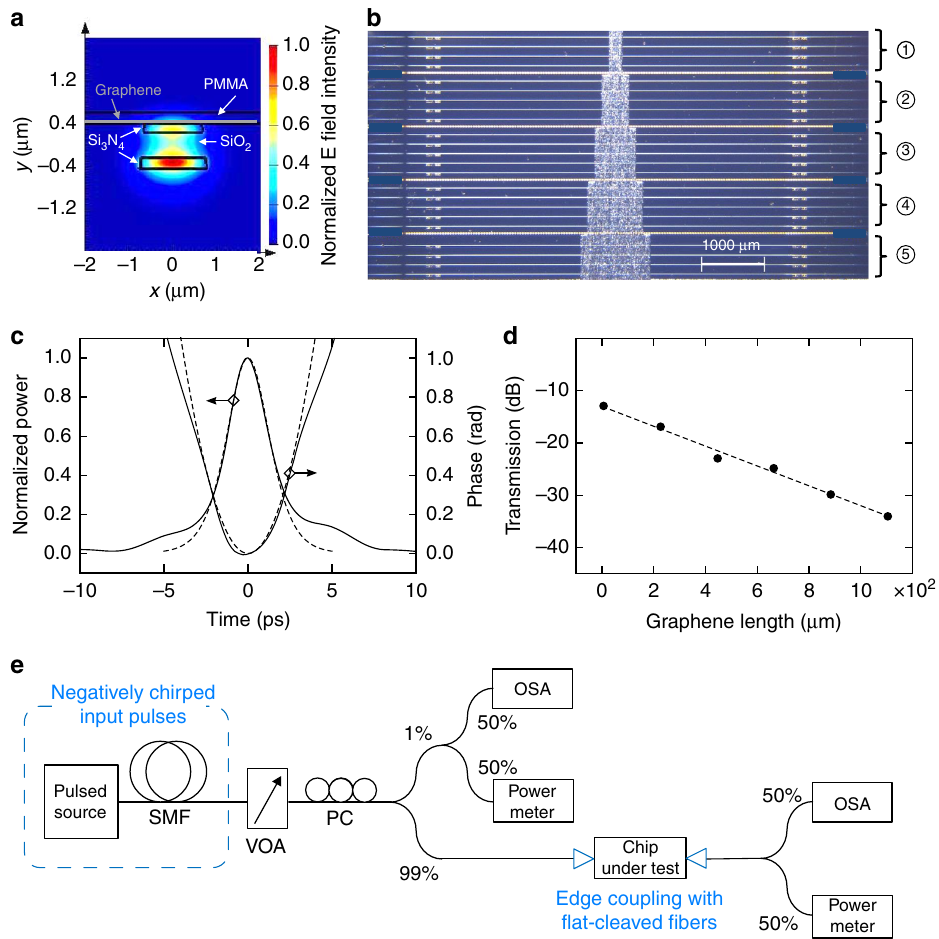
Fig. 1 Illustration of the setup used for the experiments and its constituents. a Cross-section of the SiO 2 -core waveguides covered by graphene with poly (methyl methacrylate) (PMMA), and numerically simulated distribution of the electric ( E ) fi eld intensity. b Top-view microscope image of the SiO 2 -core waveguides with regions 1 – 5 covered by, respectively, 220, 440, 660, 880, and 1100 μ m-long graphene sections with PMMA (white areas in center). c Temporal power pro fi le and phase pro fi le of the negatively chirped input pulse measured with the frequency-resolved optical gating (FROG) technique (solid curves) and the corresponding fi t assuming a quadratic phase pro fi le with C 0 = − 0.2 and T FWHM,0 = 3 ps (dashed curves). d Waveguide transmission as a function of graphene length as measured (dots) and the corresponding linear fi t with slope α eff = 4605 m − 1 (dashed curve). e Setup for the transmission and spectral broadening measurements. SMF single-mode fi ber, VOA variable optical attenuator, PC polarization controller, OSA optical spectrum